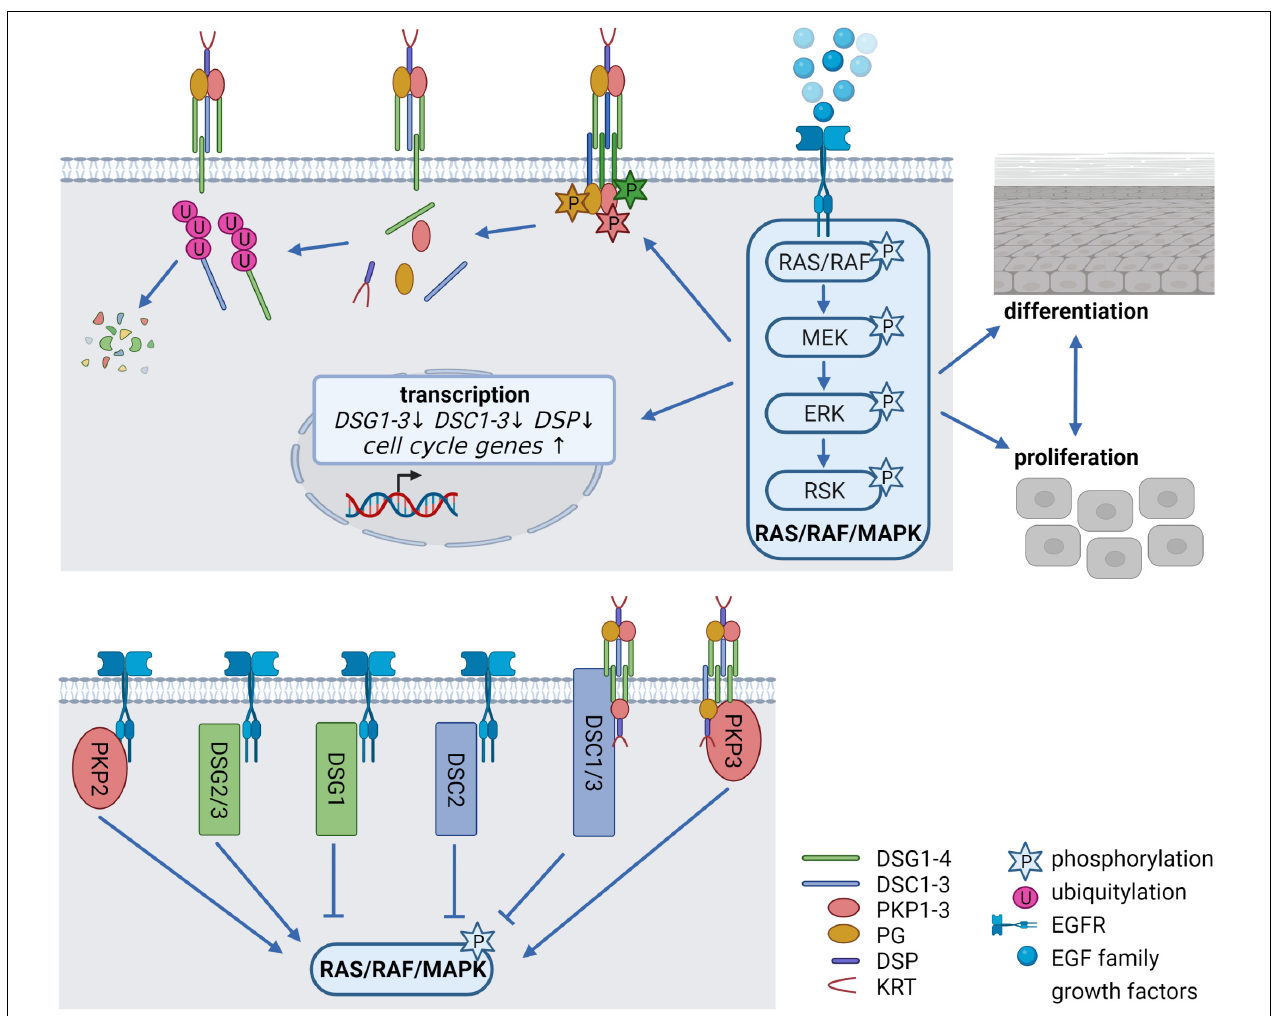
FIGURE 2 | Epidermal growth factor receptor (EGFR) signaling as a critical regulator of desmosomes (created with biorender.com) . (Upper panel) Modification of desmosomes by EGFR signaling. Binding of EGF family growth factors to their receptors activates the canonical RAS/RAF/MAPK signaling pathway. Several kinases of the pathway can phosphorylate desmosomal cadherins and PKPs, thereby affecting their stability as well as their localization at the cell membrane. At the same time, EGFR signaling alleviates transcription of desmosomal genes and promotes cell cycle gene expression thereby controlling the balance between proliferation, differentiation and cell-cell adhesion. (Lower panel) Impact of desmosomal proteins on EGFR signaling. The desmosomal cadherins DSG1-3 and DSC2 as well as PKP2 co-localize or interact with the EGFR at the cell membrane, thereby either activating or inhibiting RAS/RAF/MAPK signaling. DSC1/3 and PKP3 affect RAS/RAF/MAPK signaling probably without interfering directly with the